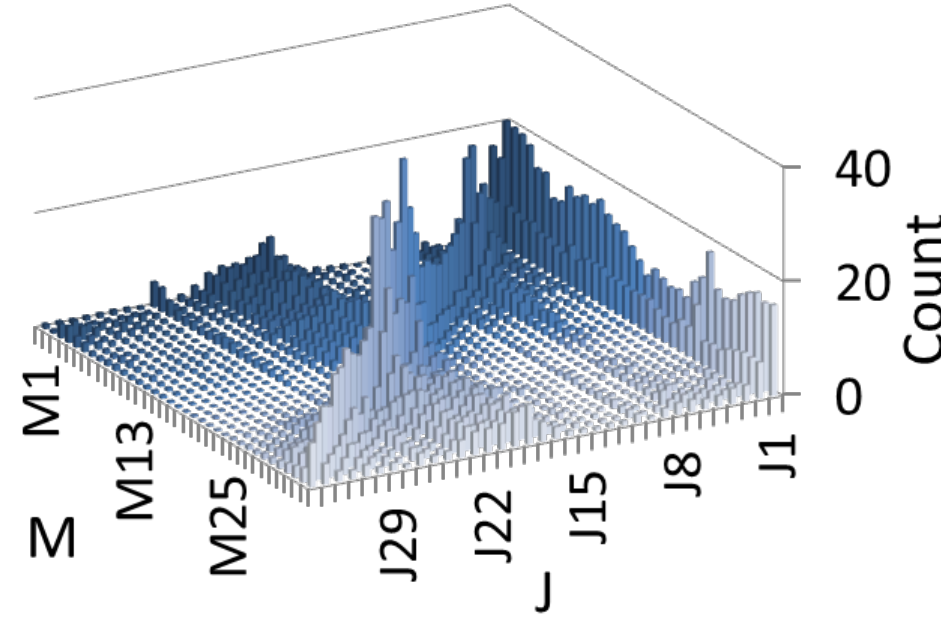
Figure 4. Probabilities of intra mode based on its neighboring